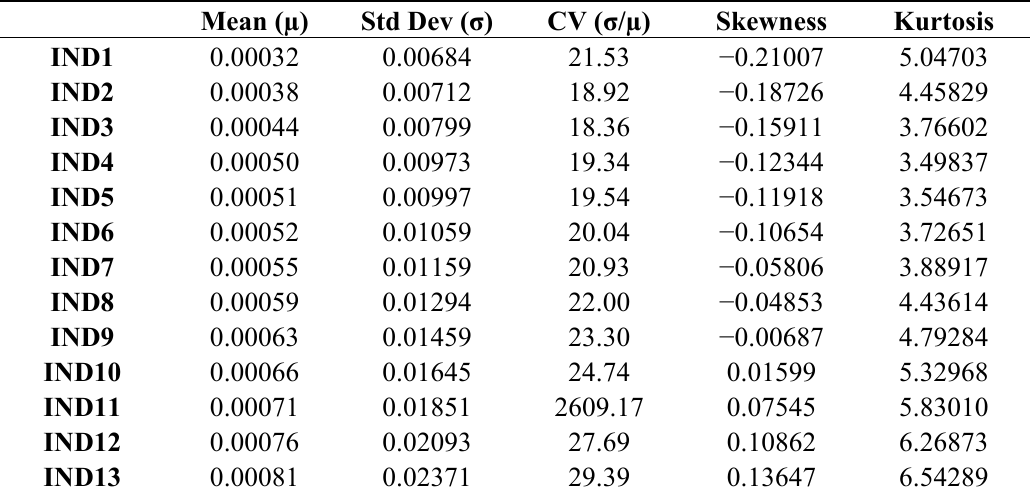
Table 3. Summary statistics of the international MV efficient diversified